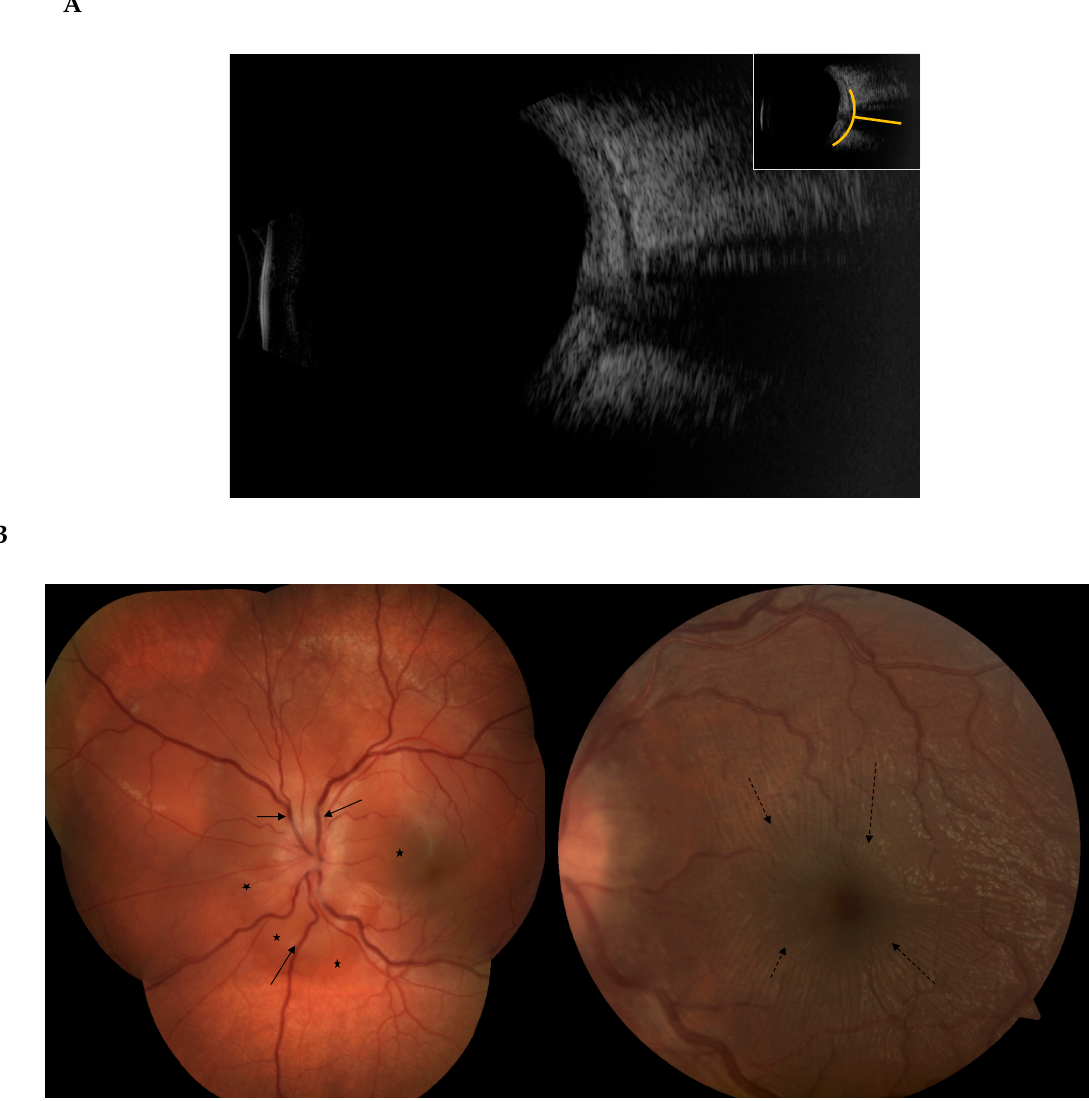
Figure 7. Posterior scleritis. The scleral inflammation involves the posterior part of the globe, with no apparent external sign unless there is an associated anterior component. ( A ) B-scan ultrasound showing the classic T-sign from scleral oedema, ( B ) The scleral inflammation can cause exudative retinal detachment (*), retinal folds (dashed arrows), retinal veins congestion (arrows) and optic disc swelling.